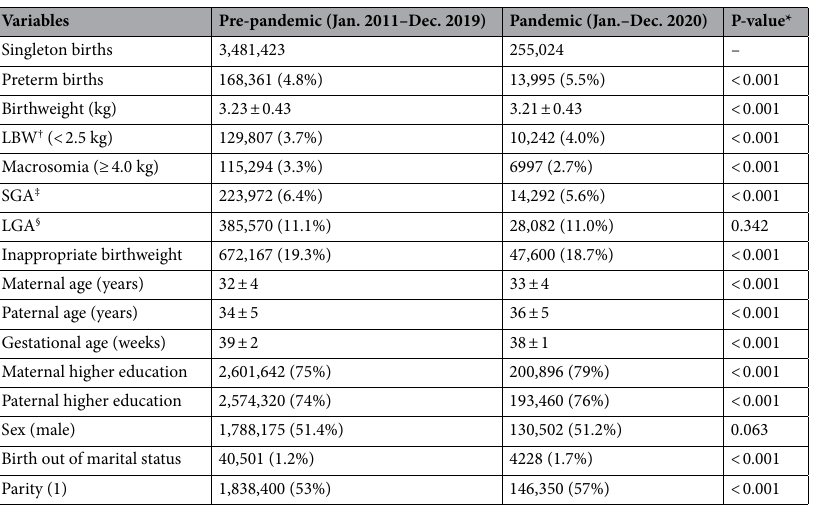
Table 1. Differences in birth outcomes between pre-pandemic and pandemic period. Frequency, proportion, and means of deliveries with birth outcomes and covariates used in the multivariable generalized linear regressions in the pre-pandemic (January 2011–December 2019) and SARS-CoV-2 pandemic (January 2020–December 2020) periods are shown. *P-values from a two-sample test for equality of proportion with continuity correction for preterm birth, underweight birth, overweight birth, SGA, LGA, and inappropriate birthweight. A P-value from Welch’s two-sample t-test for birthweight. † LBW: low birthweight, < 2.5 kg. ‡ SGA: small for gestational age. § LGA: large for gestational age.